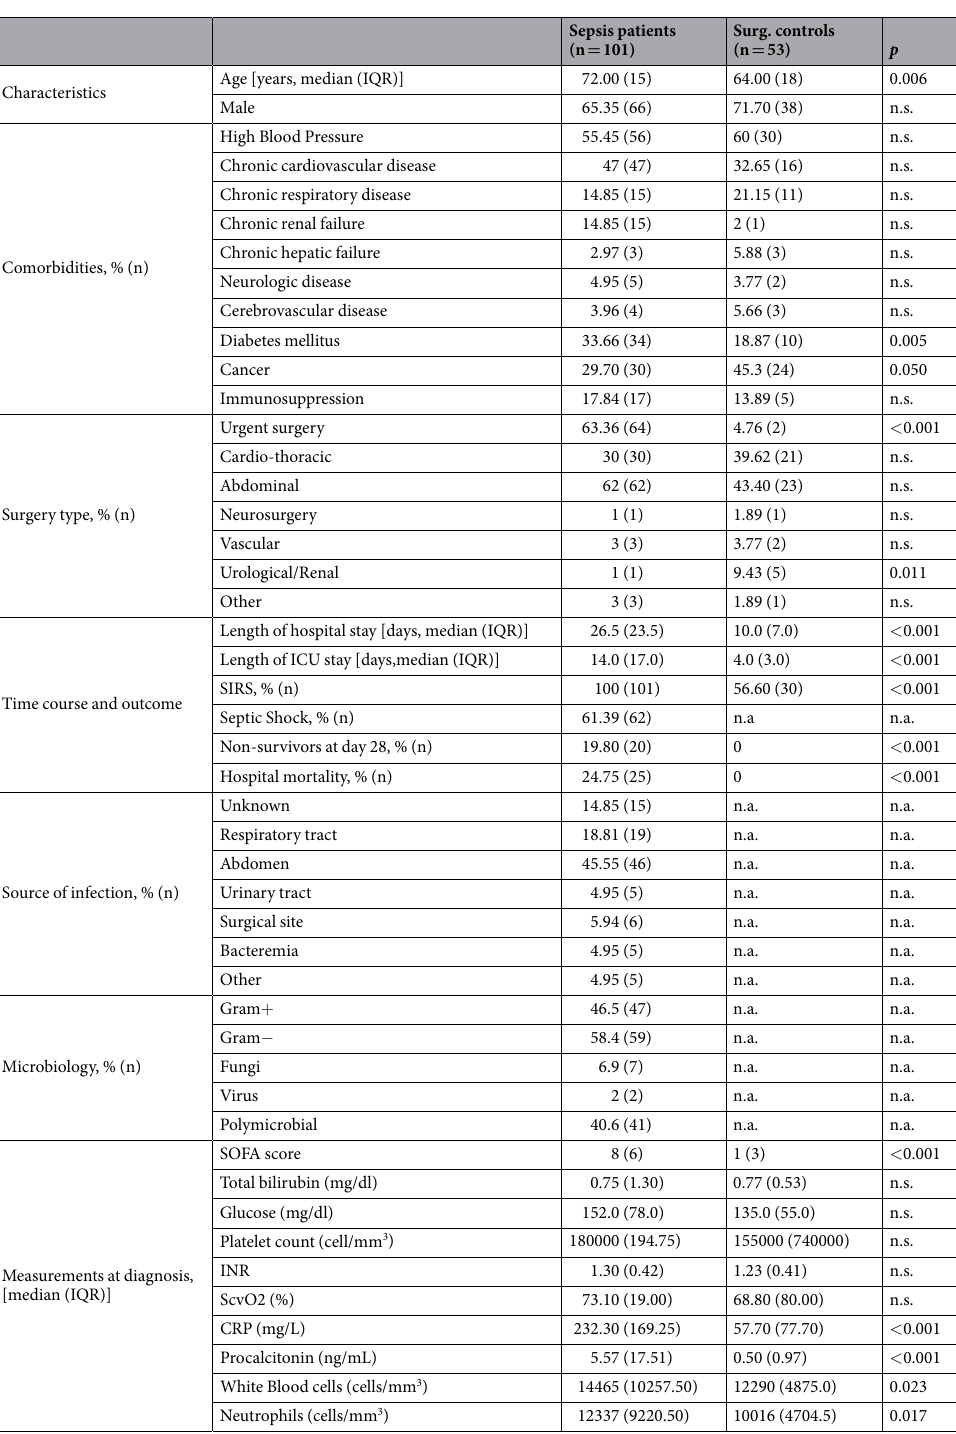
Table 1. Clinical characteristics of the patients in the derivation cohort: continuous variables are represented as median, (interquartile range, IQR); categorical variables were represented as (%, n). ICU: intensive care unit; SIRS: systemic inflammatory response syndrome, SOFA: Sequential Organ Failure Score; CRP, C reactive protein; INR, international normalized ratio; ScvO2: Central venous oxygen saturation; n.s: not significant; n.a: not